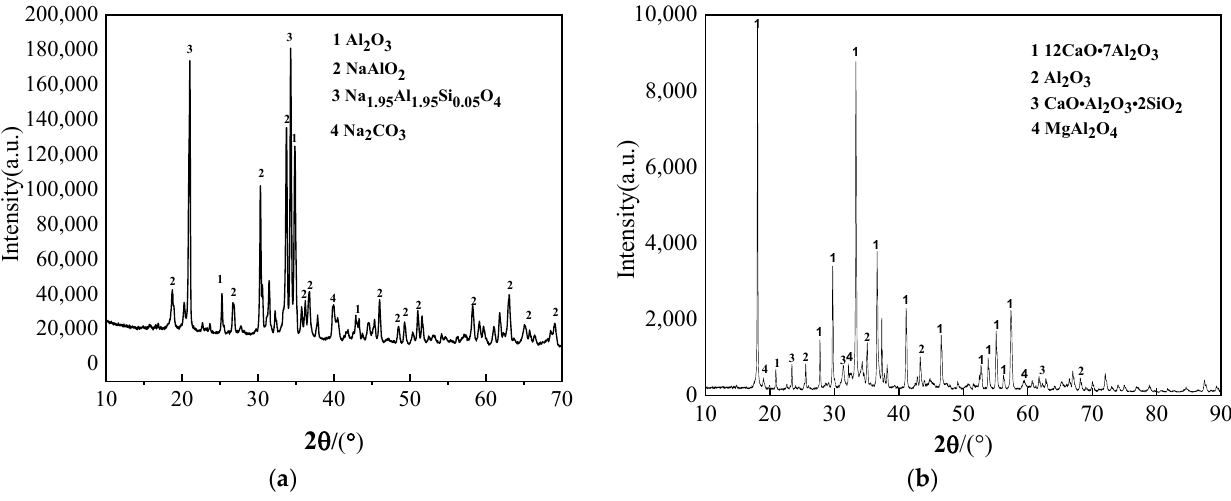
Figure 7. XRD of roasted samples with sodium carbonate and calcium oxide. ( a ) Add sodium carbonate; ( b ) Add calcium oxide.